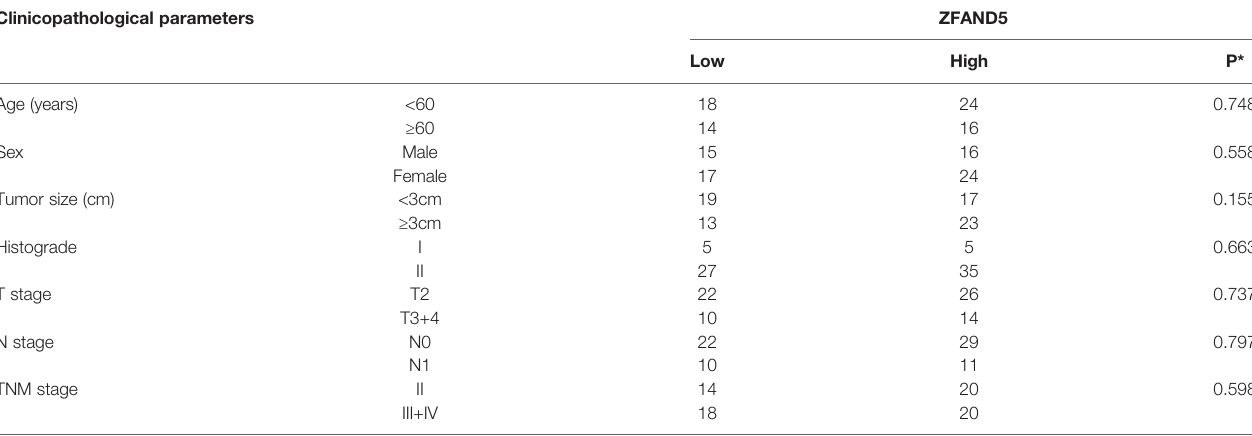
TABLE 2 | The correlation between ZFAND5 and clinicopathological parameters. Clinicopathological